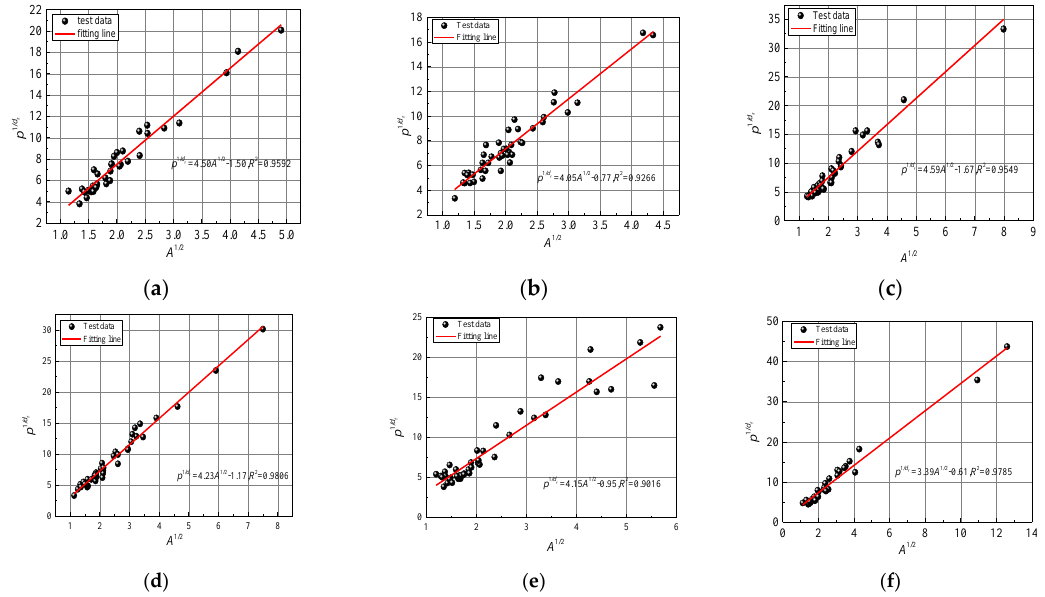
Figure 15. The Relationship between p 1/ d f and A 1/2 . ( a ) F-T = 0, ( b ) F-T = 1, ( c ) F-T = 3, ( d ) F-T = 6, ( e ) F-T = 10, ( f ) F-T = 15.